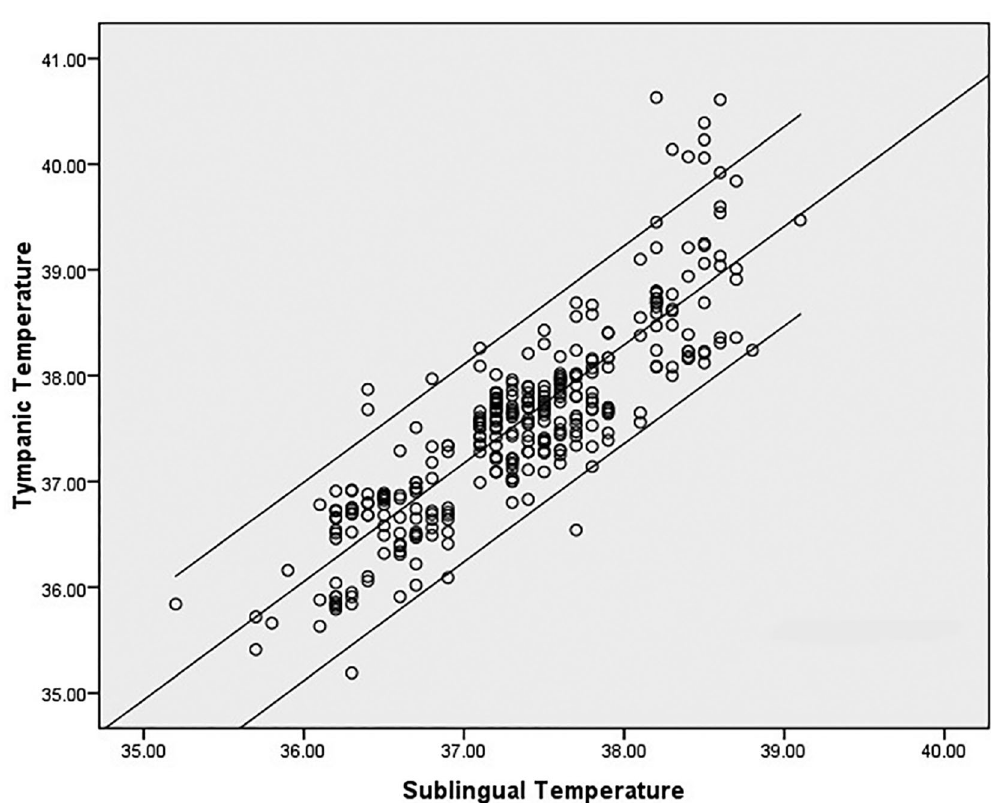
Figure 2. Correlation between tympanic and sublingual temperature ( ° C)